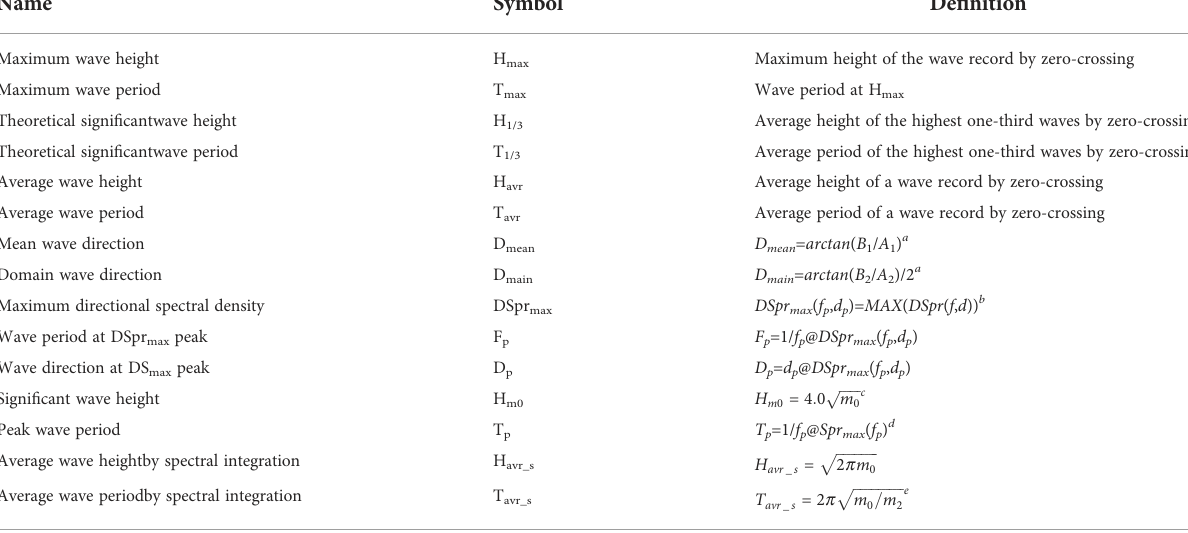
TABLE 1 De fi nition of the wave